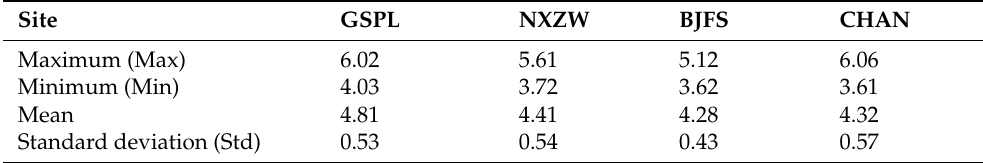
Table 1. The uncertainty of ZNHD (unit: